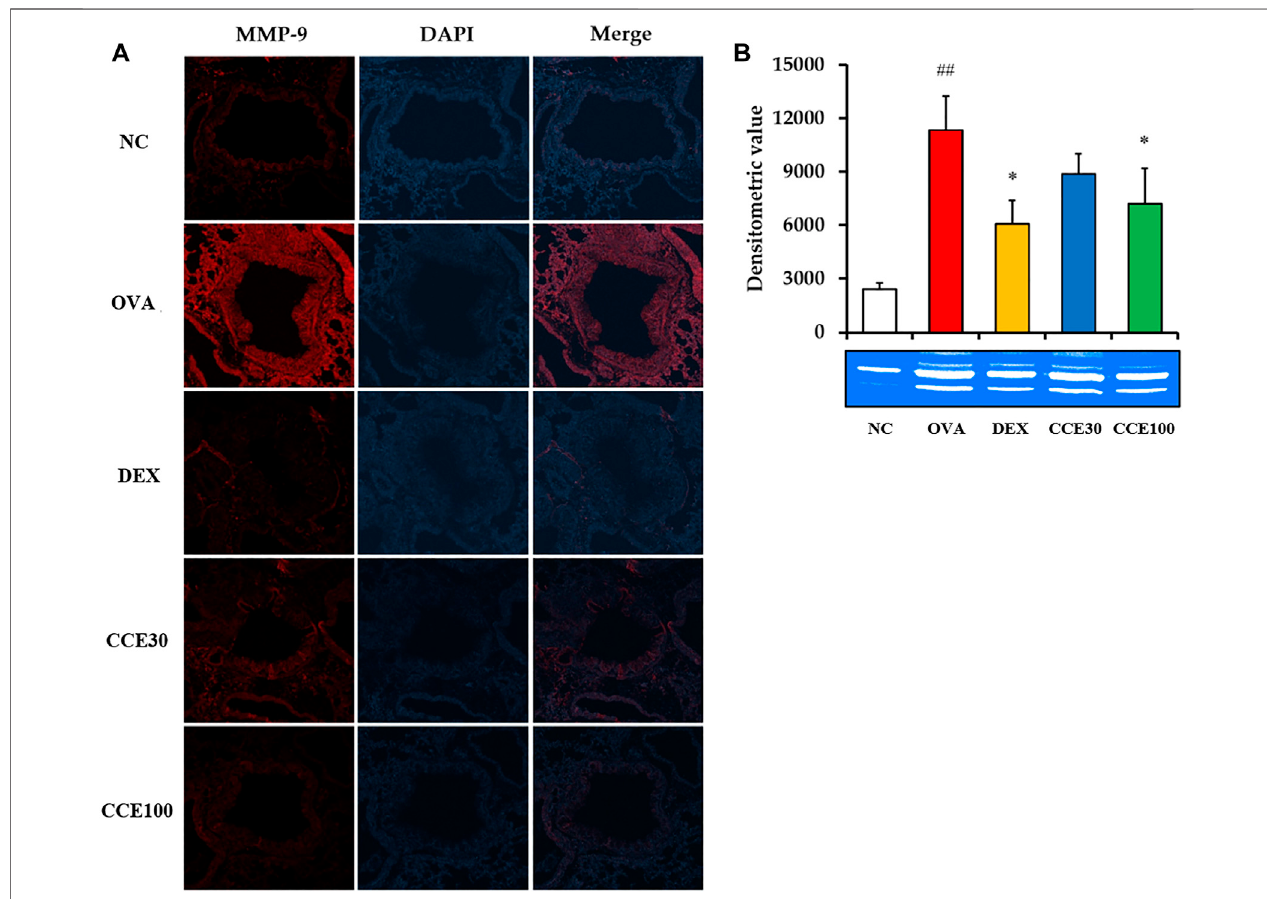
FIGURE 7 | CCE decreased the expression and activity of MMP-9 in OVA-exposed mice. (A) Representative fi gure of MMP-9 expression, (B) gelatin zymograph. NC,nonasthmaandPBStreatment;OVA,asthmaandPBStreatment;DEX,asthmaanddexamethasonetreatment;CCE30andCCE100,asthma,andCCEtreatment (30 mg/kg and 100 mg/kg, respectively). ## p < 0.01, vs . NC; * p < 0.05, vs . OVA ( n = 3 per group).